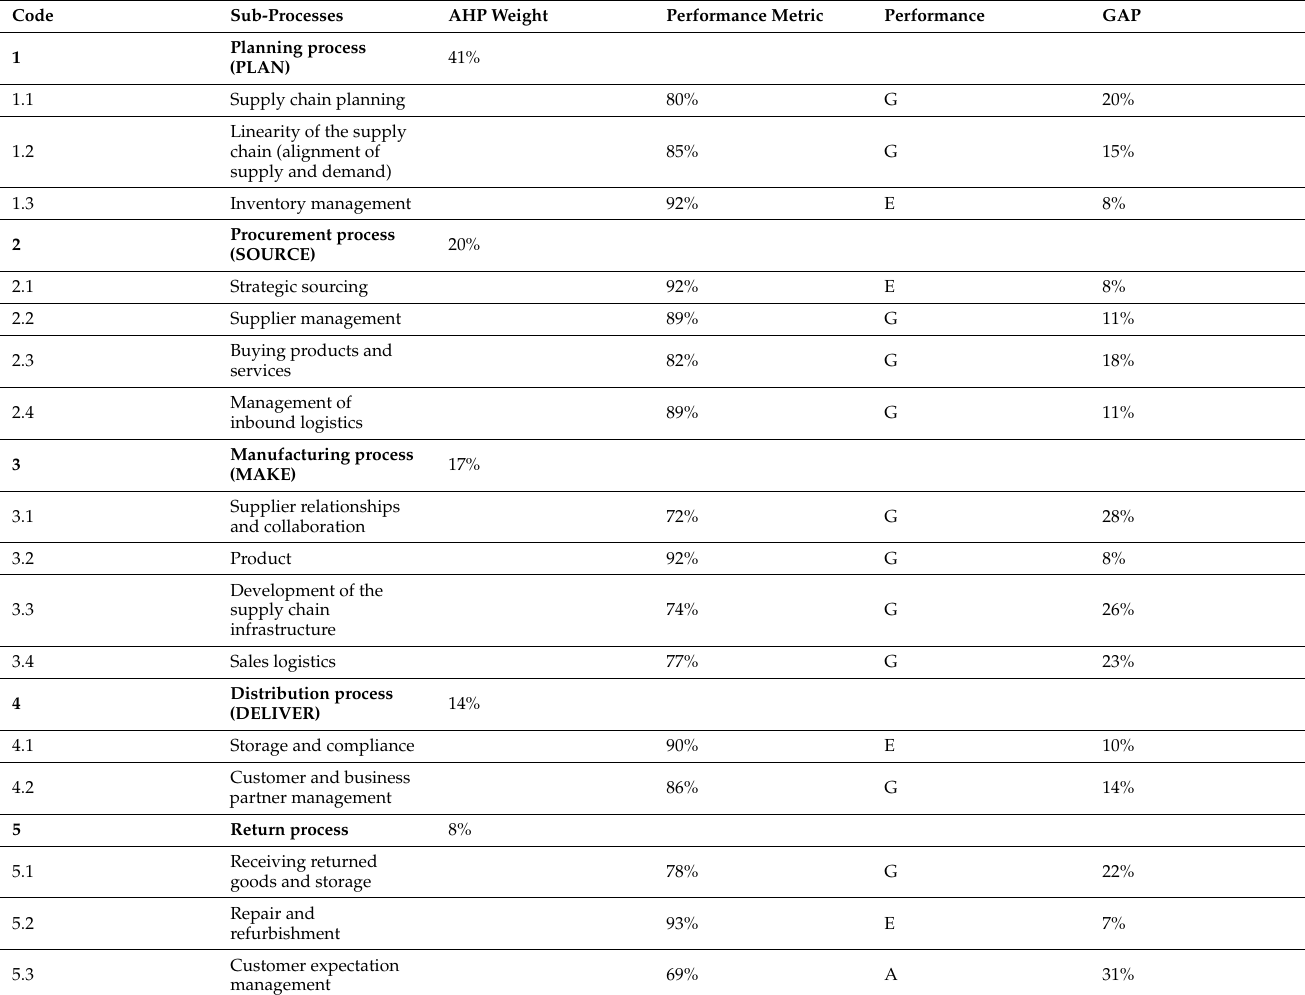
Table 9. Supply chain performance GAPs at the sector level by